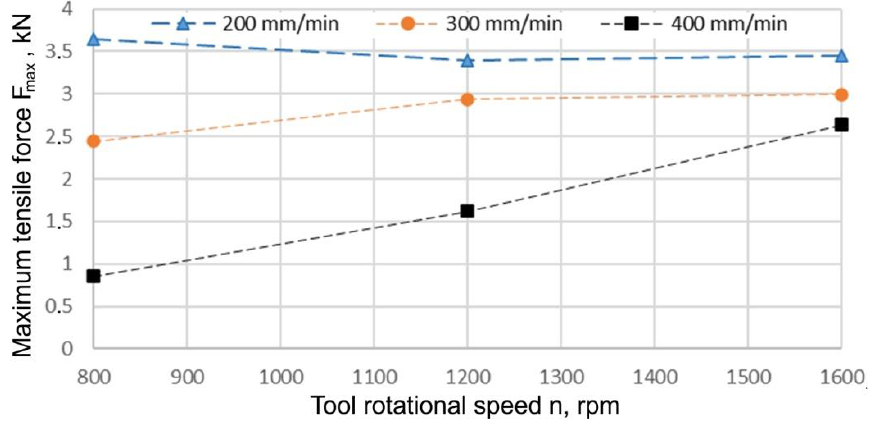
Figure 15. Effect of the tool rotational speed and welding speed on the maximum force transmitted by the joint F max (x 1 = 1.9 mm).